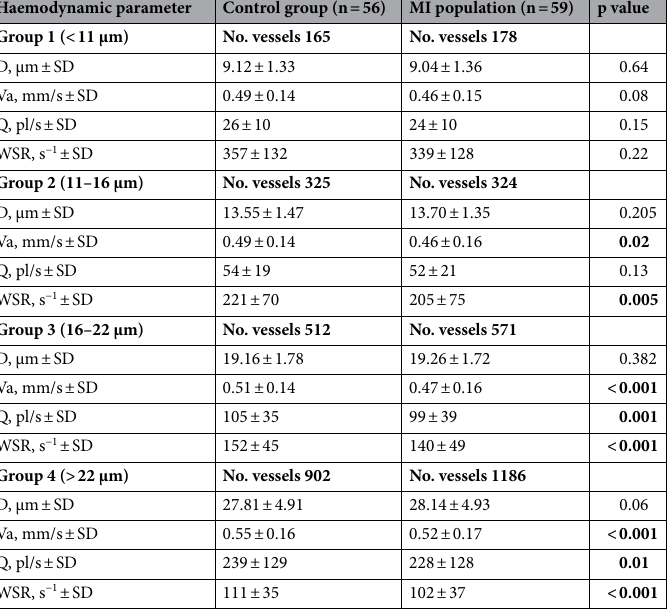
Table 5. Comparison of conjunctival microcirculatory parameters based on vessel group. Bold values are statistically significant (p < 0.05). D diameter, SD standard deviation, Va axial velocity, Q blood volume flow, WSR wall shear rate, MI myocardial infarction.